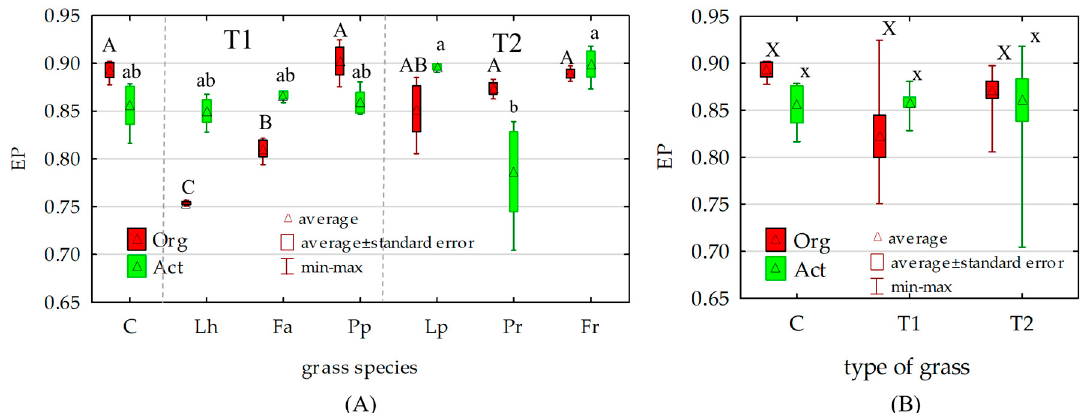
Figure 3. Ecophysiological diversity index (EP) of organotrophic bacteria (Org) and actinobacteria (Act): ( A ) depending on the species of grass, ( B ) depending on grass type (fodder or lawn). Homogeneous groups denoted were calculated separately for each microorganisms, groups denoted with letters (a–c) were calculated for the species of grass and groups denoted with letters (x) were calculated for the type of grass. C—unsown soil; Lh— Lolium x hybridum Hausskn; Fa— Festuca arundinacea ; Pp— Phleum pratense , Lp— Lolium perenne , Pr— Poa pratensis ; Fr— Festuca rubra.